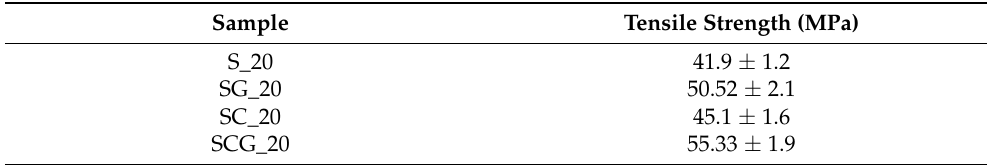
Table 2. Mean values of tensile strength of films prepared.